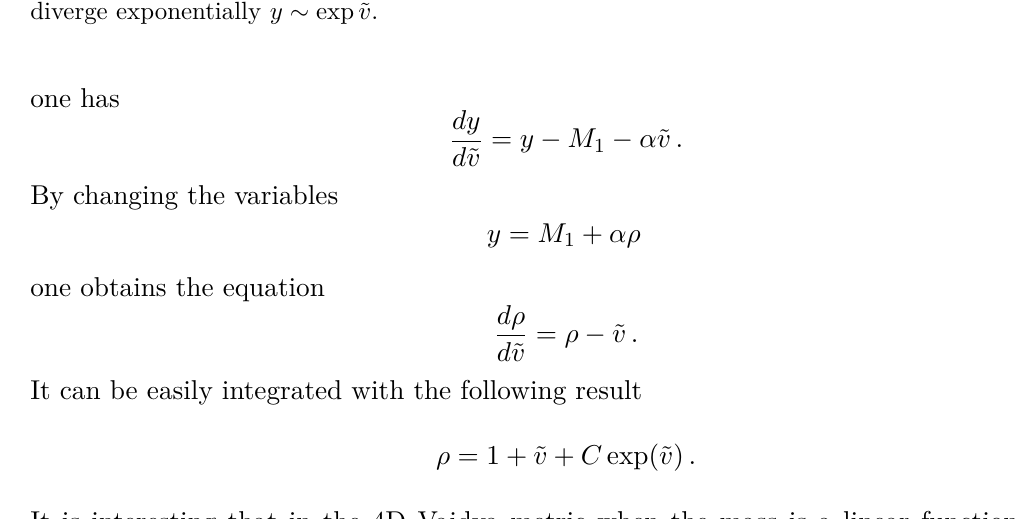
Figure 4. Spacetime of 2D limited curvature black hole with the mass parameter M (˜ v ) which is approximately linear during the stage of the black hole formation and after a short period transitions to a slow linear evaporation stage. Before the BH formation and after its evaporation the null rays diverge exponentially y ∼ exp ˜ v